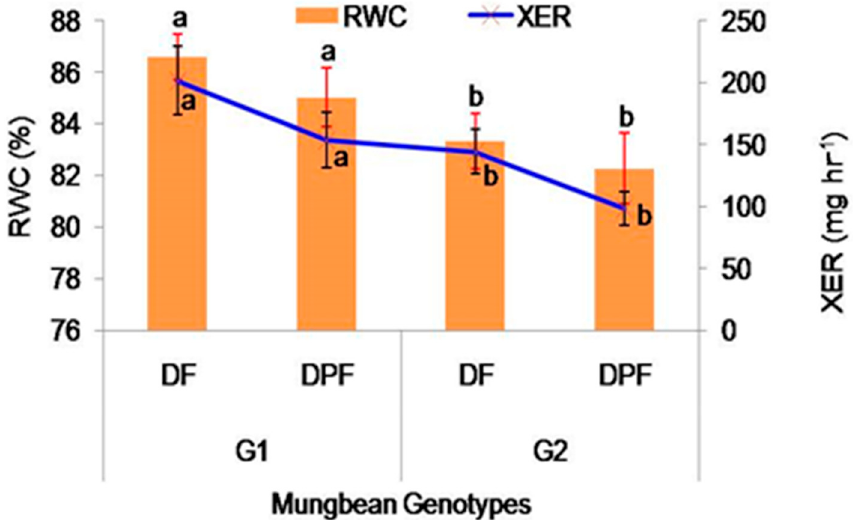
Figure 3. Water status (RWC and XER) of selected mung bean genotypes at the DF and DPF stages (Data followed by the same letter are not differed significantly by LSD test at p < 0.05).